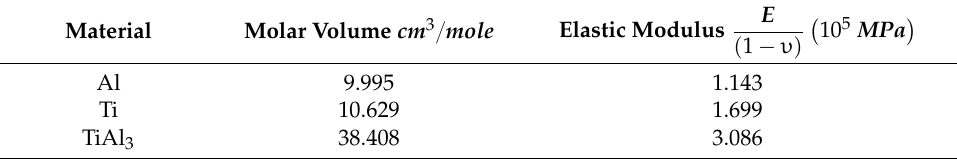
Figure 12. High magnification SEM micrographs of the mixed powder bulk heated at 640 °C for ( a ) 90 min; ( b ) 210 min; ( c ) 210 min.